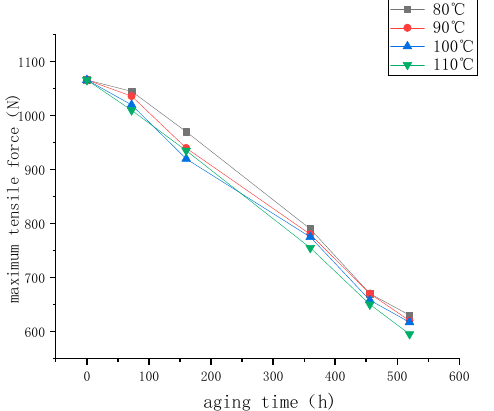
Figure 3. The relationship between the maximum tensile force of the pipe and the aging time (PE80, 0 MPa).